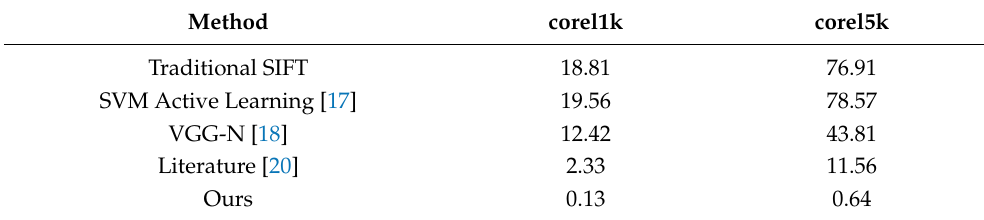
Table 3. Retrieval time of different methods on data sets corel1k and corel5k